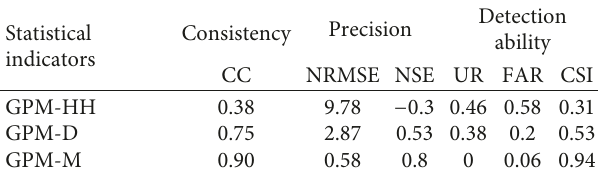
Table 3: Adaptability index at different timescales (CC, NRMSE, NSE, UR, FAR, and